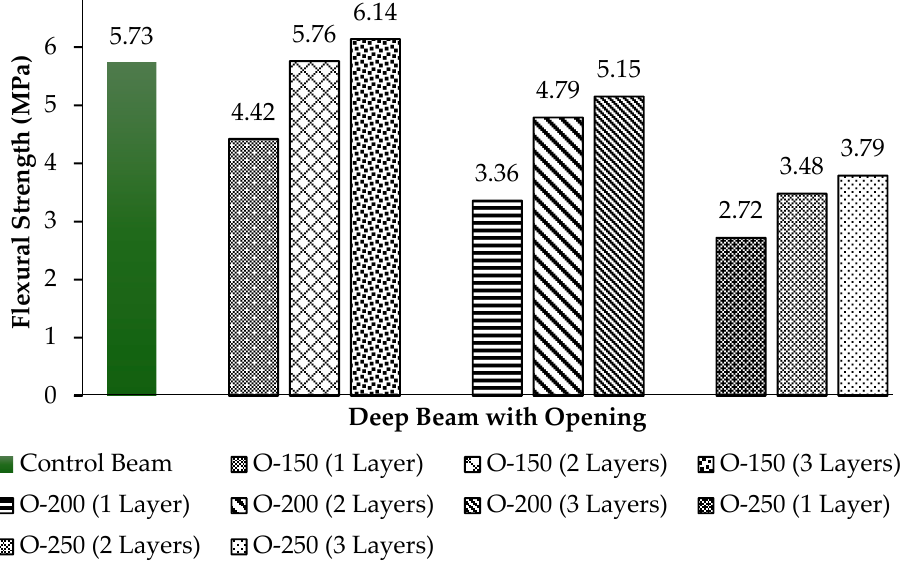
Figure 19. Flexural strength results of control deep beam and 3 groups of deep beams with opening.